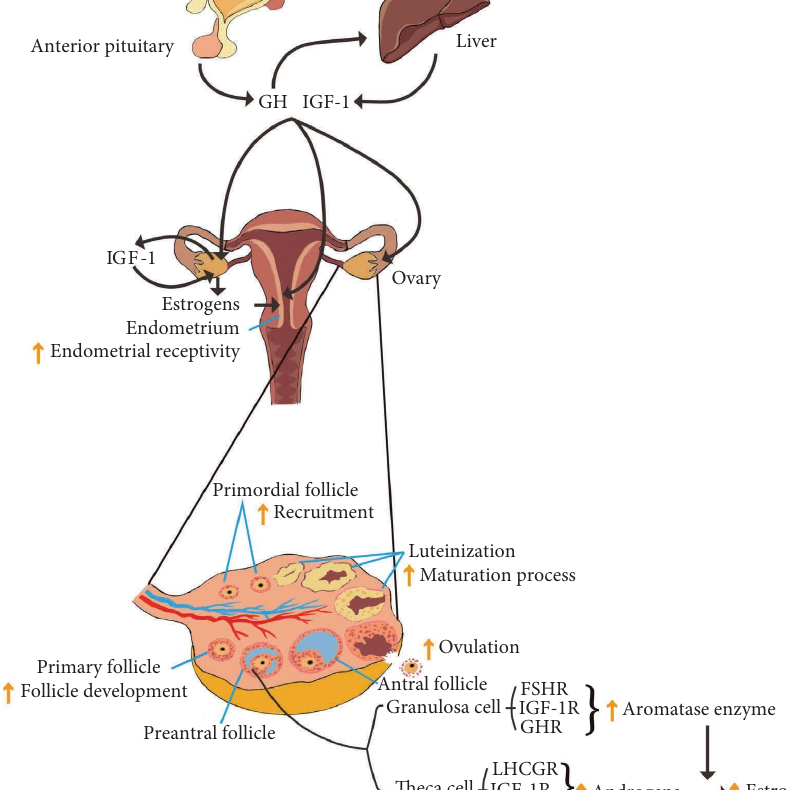
Figure 2: GH/IGF-1 roles in reproduction of adult females and potential mechanisms. Systemic GH/IGF-1 stimulates ovarian IGF-1 production. GH of ovarian origin is not fully confrmed and is not shown in the fgure. Systemic GH/IGF-1 and/or ovarian IGF-1 play roles. Tey contribute to the recruitment of primordial follicles and promote the growth and development of follicles. Tey are able to improve the FSH action on the granulosa cell and promote the LH action on the theca cell. Subsequently, steroidogenesis is ameliorated. Tey can also induce ovulation and support the maturation process of luteinization. Te efect of GH/IGF-1 on the endometrium is to improve en- dometrial receptivity. GH/IGF-1 can also contribute to an increase in endometrial receptivity by raising estrogen levels. GHR: growth hormone receptor; IGF-1R: insulin-like growth factor-1 receptor; LHCGR: luteinizing hormone/choriogonadotropin receptor; FSHR: follicle-stimulating hormone